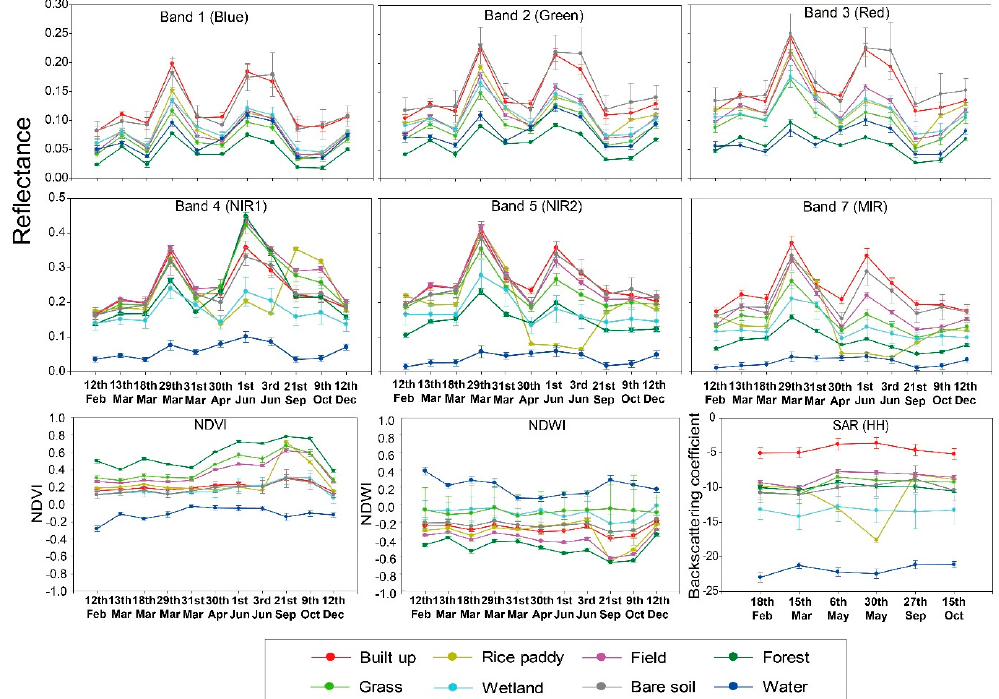
Figure 5. Phenological and spectral patterns of variables for each class (site B).